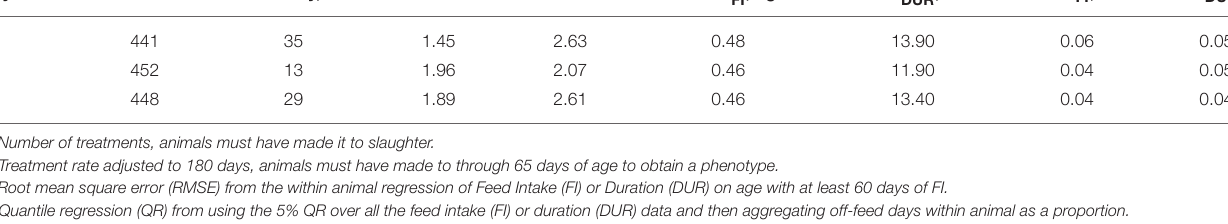
TABLE 1 | Counts and means for measures of resilience in three cycles of the natural challenge experiment ( n = 1,341 total animals entered). Cycle a Count Mortality, % TRT a TRT180 b RMSE c FI , kg RMSE c DUR , min QR FI , d QR DUR ,